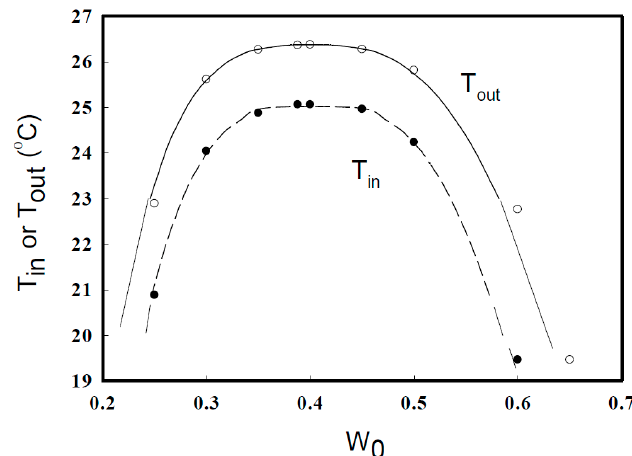
Figure 1. Temperatures at which the binary mixture of isobutyric acid – water with the weight fraction W 0 inside ( ● ) and outside ( ○ ) of the polyacrylamide gel becomes turbid upon cooling the gel in a binary mixture bath.